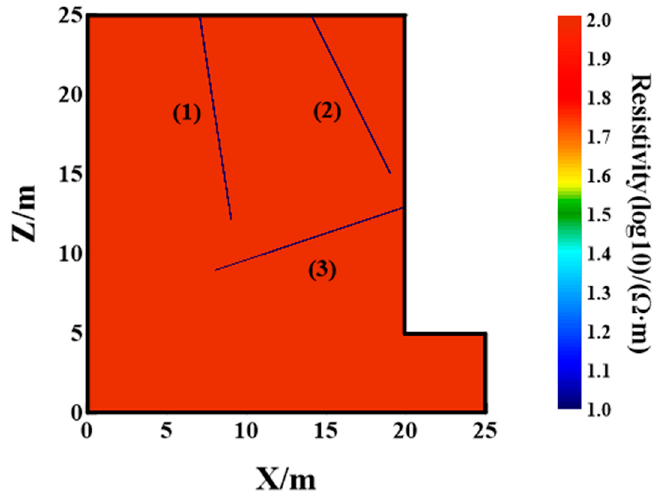
Figure 8. Grotto model with water seepage structure. (1)–(3) represent the water seepage structure. The resistivity of the grotto rock model is 100 Ω ⋅ m, the width of water seepage structure is 0.1 m, and its resistivity is 10 Ω ⋅ m.